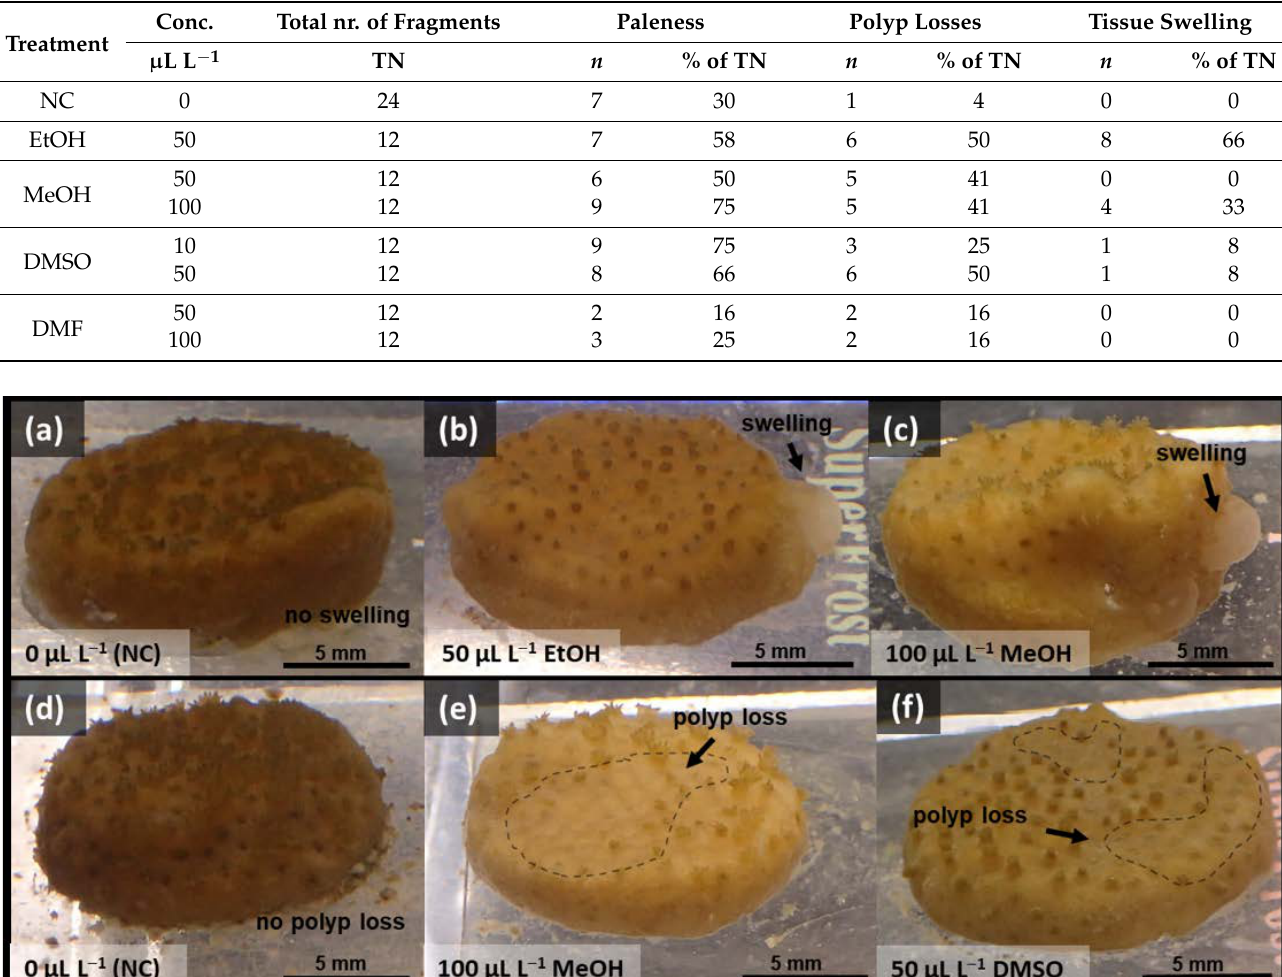
Table 1. Summary of morphological abnormalities (i.e., paleness, polyp losses, tissue swelling) on fragment level of Montipora digitata .